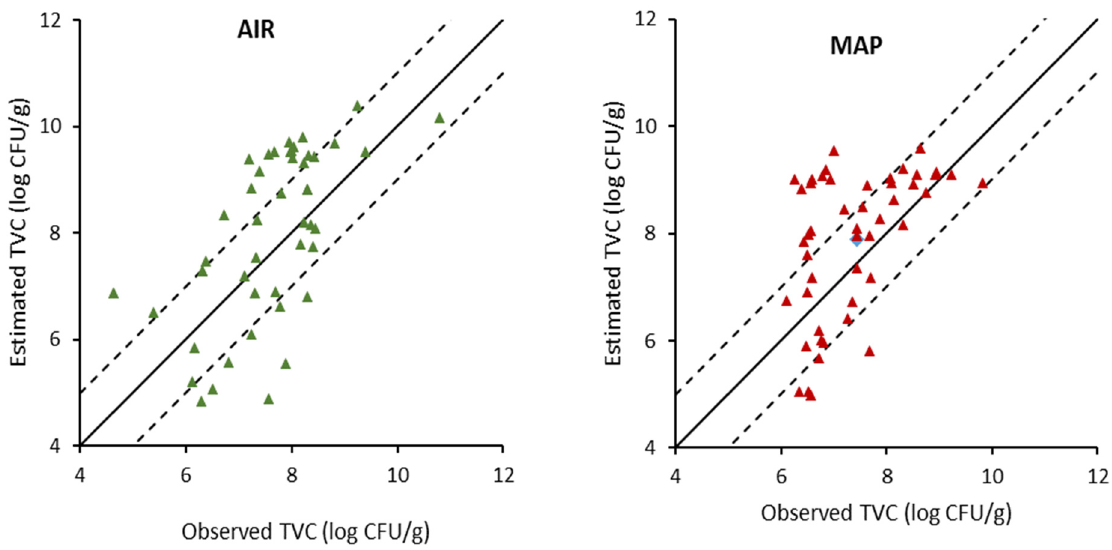
Figure 7. Correlation of observed and estimated values of total viable counts (TVC) on gilthead sea bream fillets during storage in air and MAP conditions, generated by the PLS-R models based on E-nose data. Solid line indicates the line y = x (equity); dashed lines indicate deviation of ± 1 log unit.